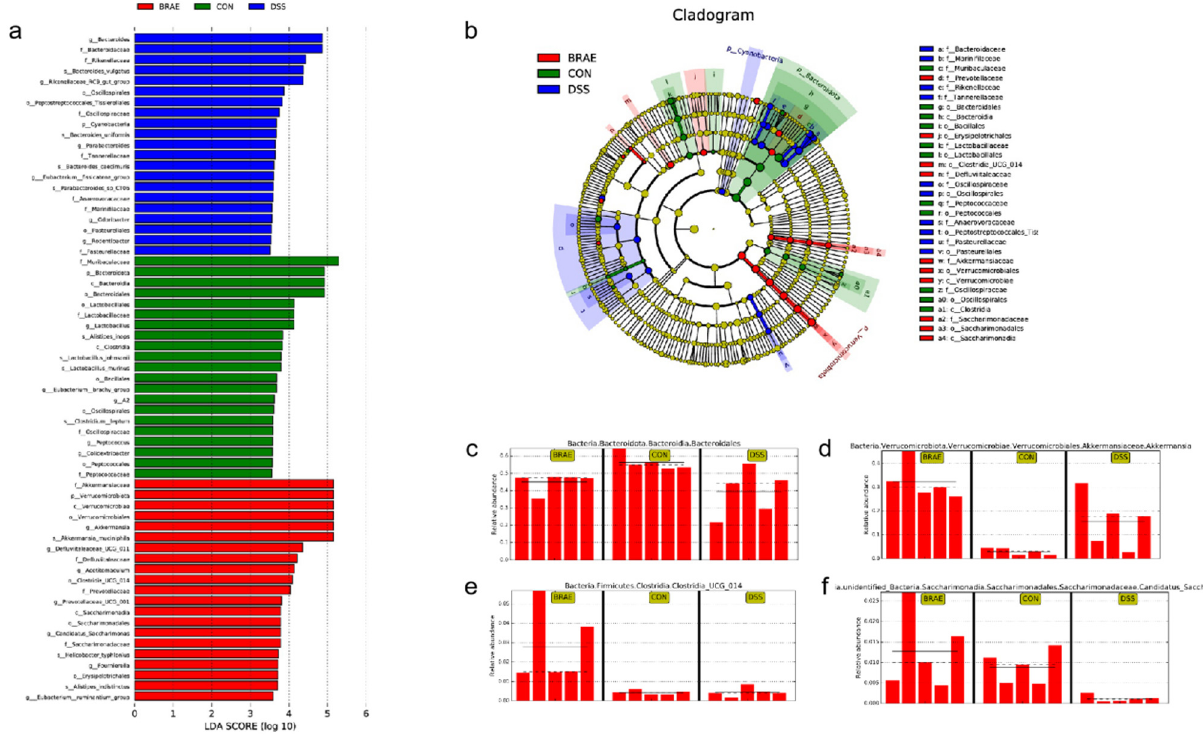
Figure 11: Species diversity of the gut microbiota analyzed by LEfSe based on LDA score. ( a ) LDA score for the bacterial taxa di ff erentially abundant ( LDA > 3.5 ) ; ( b ) cladograms generated by LEfSe indicating di ff erences in the groups; ( c – f ) gut microbiota